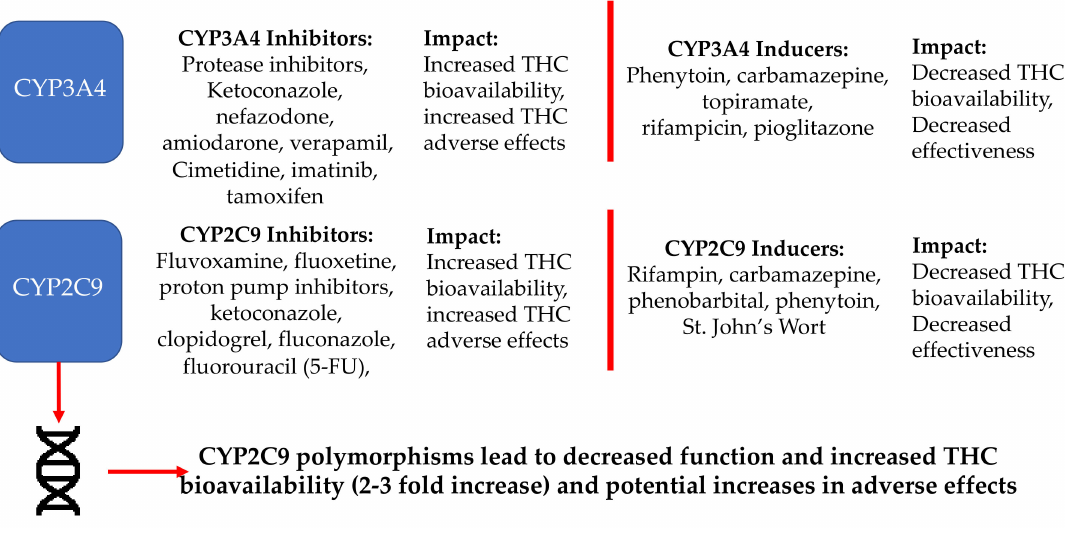
Figure 1. Potential pharmacokinetic drug–drug interactions involving key metabolism enzymes that convert THC to its metabolites for excretion.